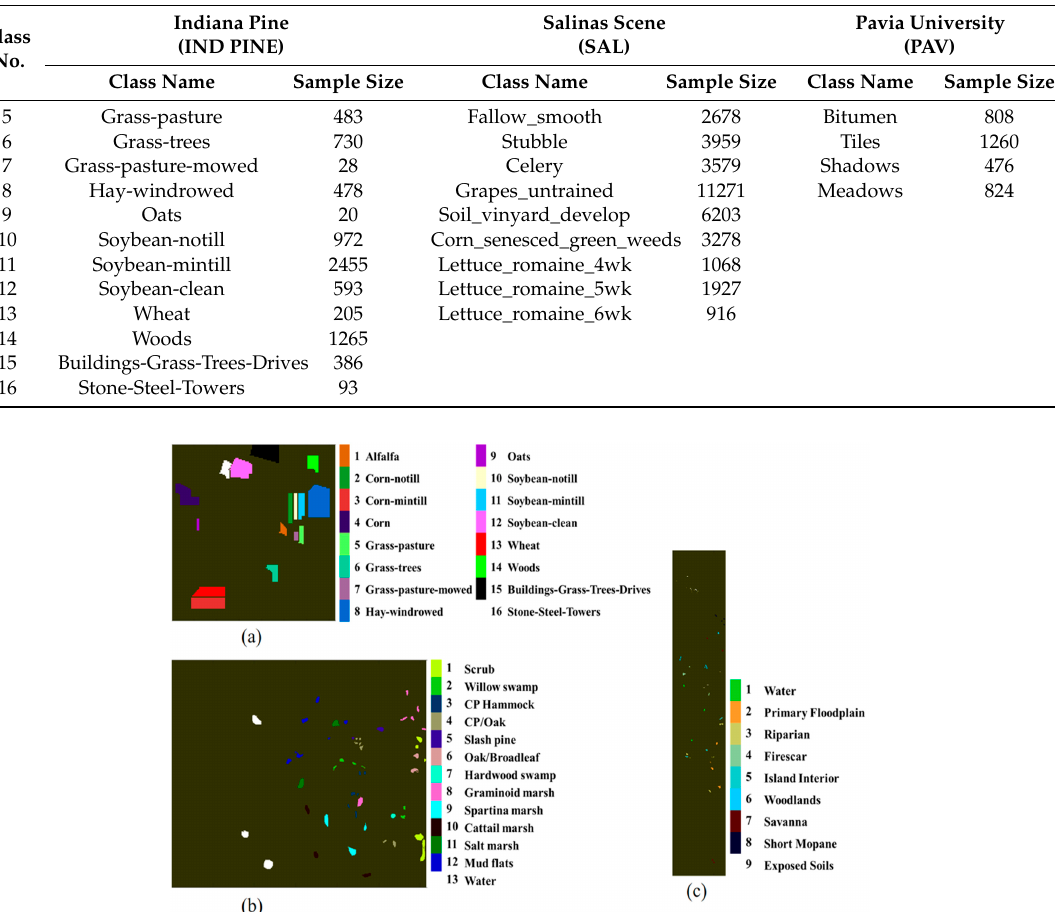
Figure 3. Ground truth of datasets in Group I. ( a ) Ground truth of the truncated Indian Pines (IND PINE) image. ( b ) Ground truth of the Kennedy Space Center (KSC) image. ( c ) Ground truth of the Botswana (BOT) image. Appl. Sci. 2020 , 10 , x FOR PEER REVIEW